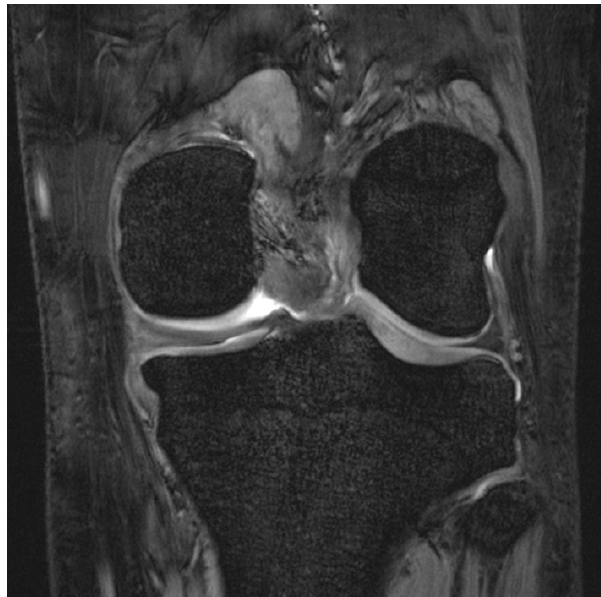
Figure 3. 7 Tesla gradient-echo image of the knee joint in the coronal plane. The cartilage layers and the menisci are shown in high resolution and exquisite detail and will help to detect even subtle pathologies of these structures. Additionally, the trabecular structure of the bones is shown in ultra-high resolution, which may promote osteoporosis